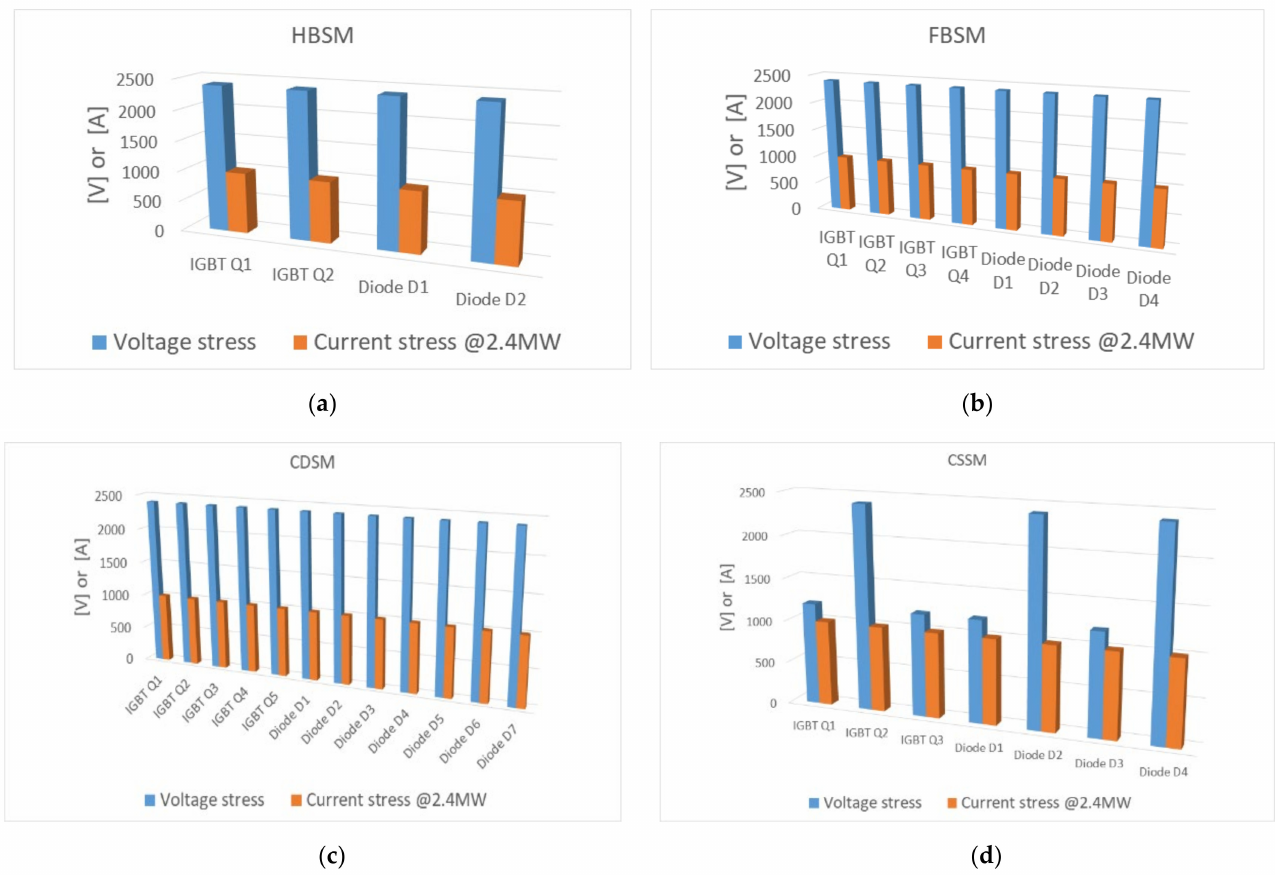
Figure 11. Comparison of voltage and current stress on the switching devices: ( a ) HBSM, ( b ) FBSM, ( c ) CDSM, ( d )